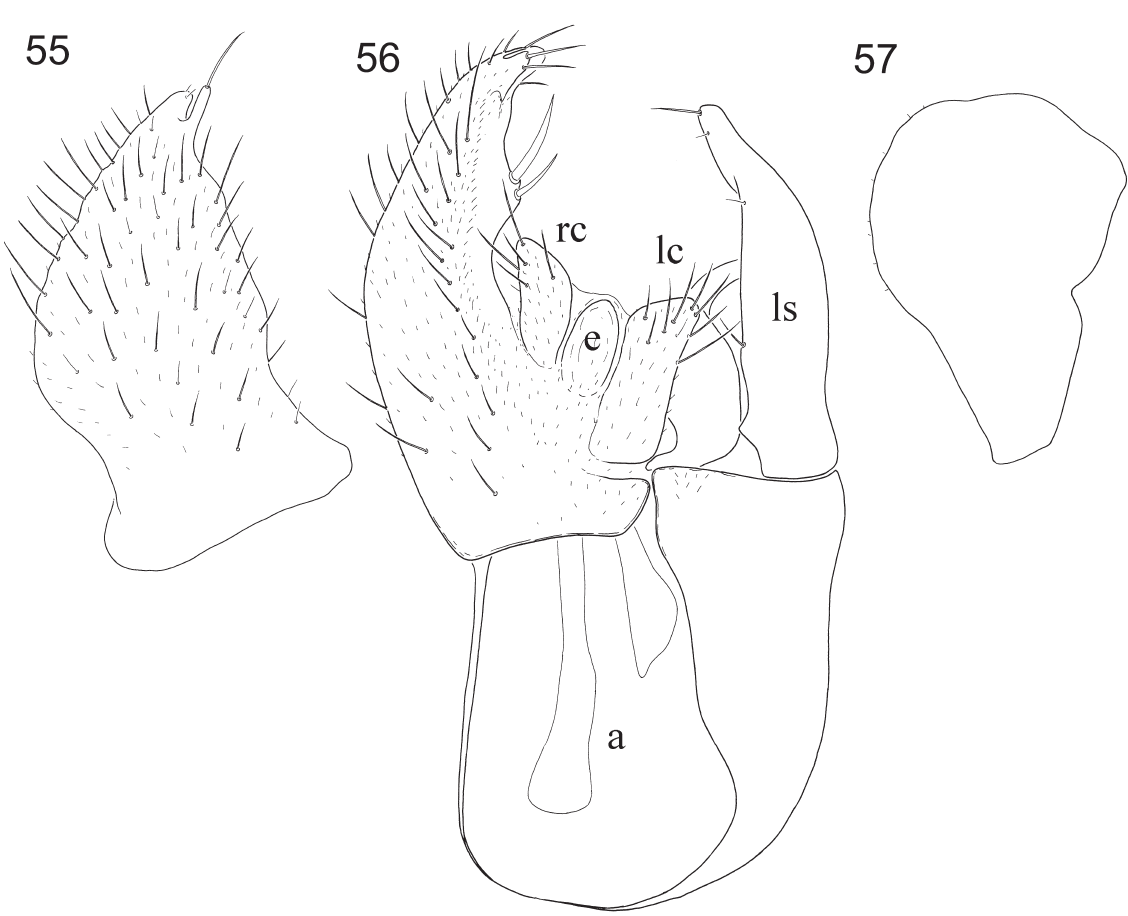
Figs 55-57. Chersodromia malaysiana sp. nov., ♂ terminalia. 55 . right epandrial lamella, lateral view. 56 . epandrium and cerci, dorsal view. 57 . left surstylus, lateral